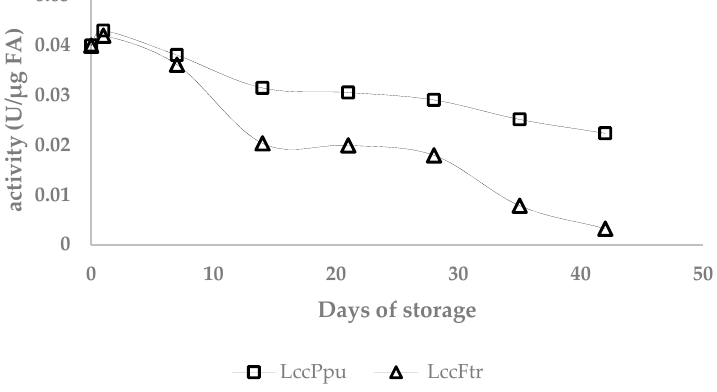
Figure 4. Activity of residual laccases in the AX gels during incubation at 25 ◦